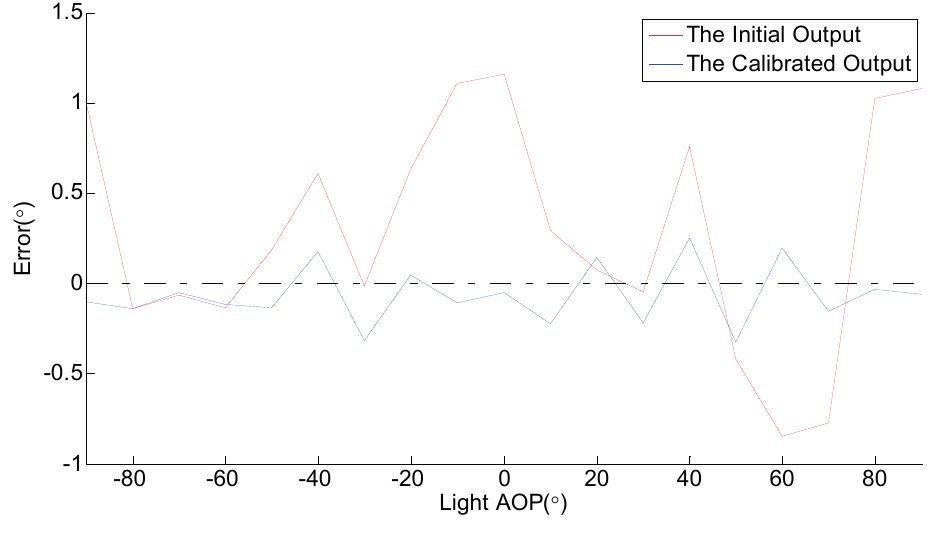
Figure 6. The error of the sensor before and after